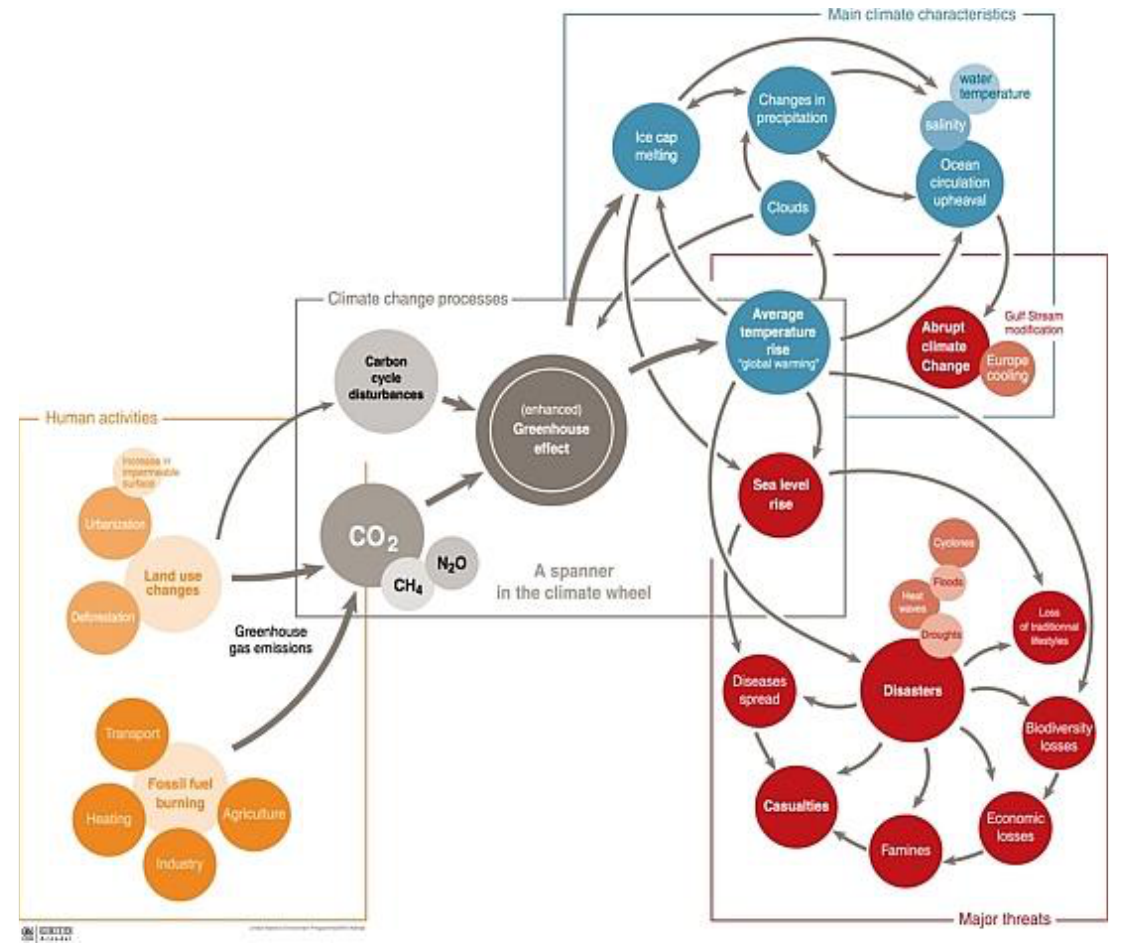
Figure 1. Climate change: processes, characteristics, and threats. Source: [2].